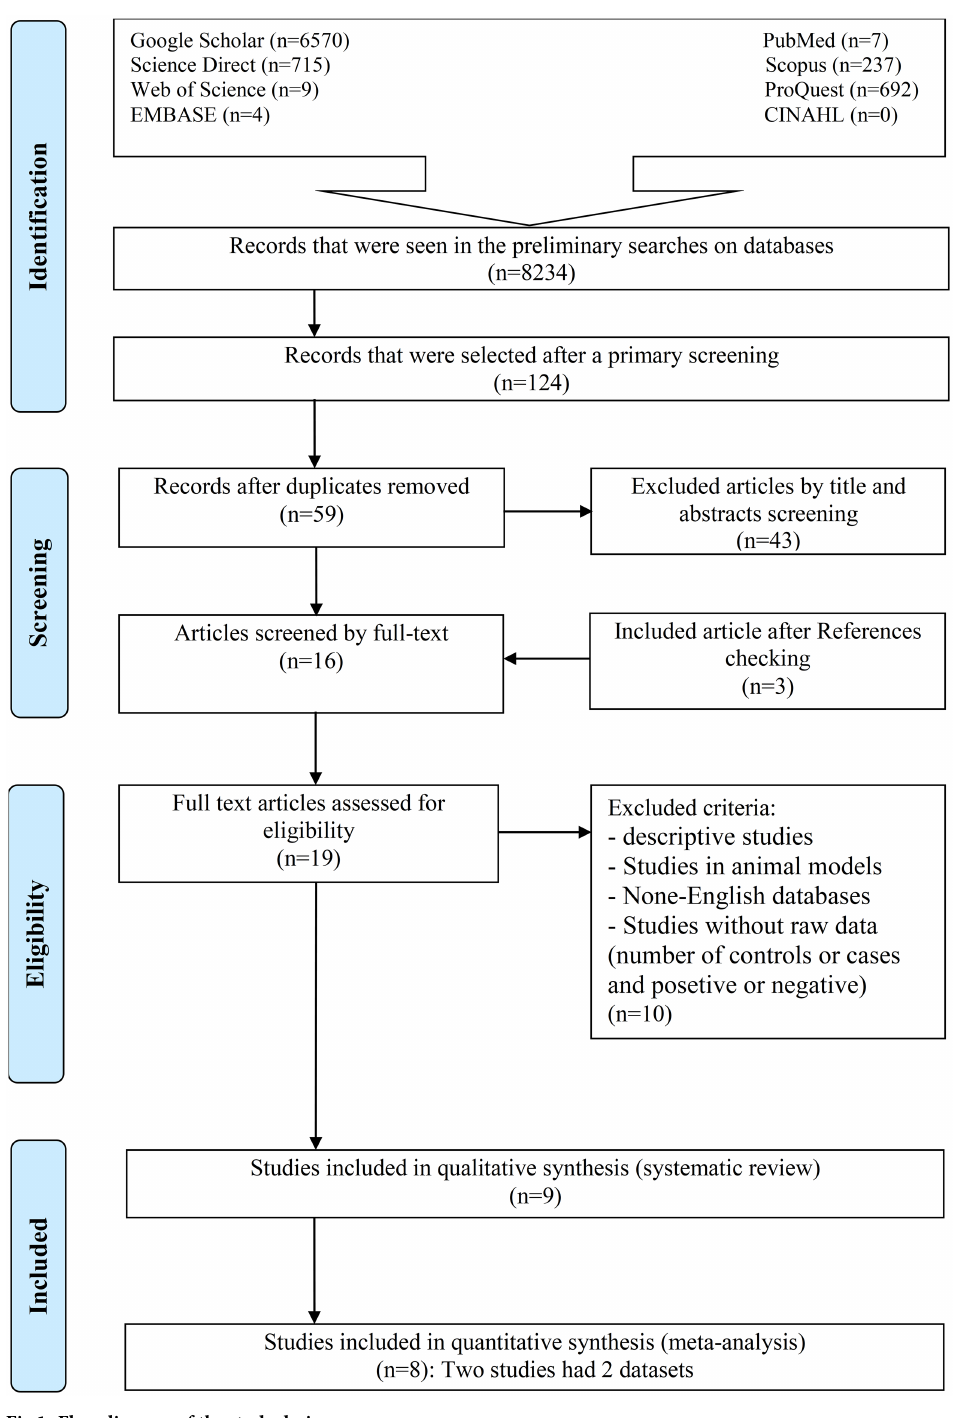
Fig 1. Flow diagram of the study design